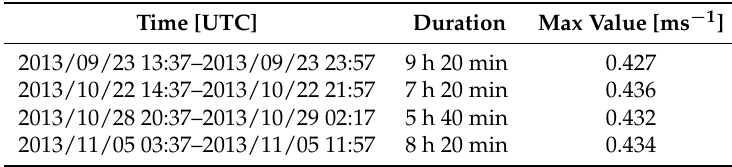
Table 3. Strongest measured current events, which exceeded 0.4 ms − 1